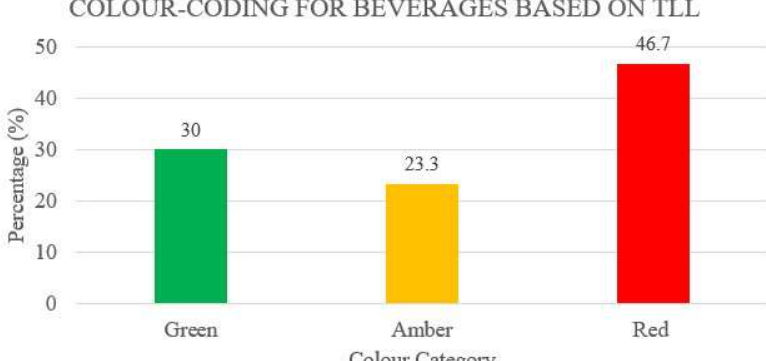
Figure 3 : Traffic light profiling for all drink items sold in the